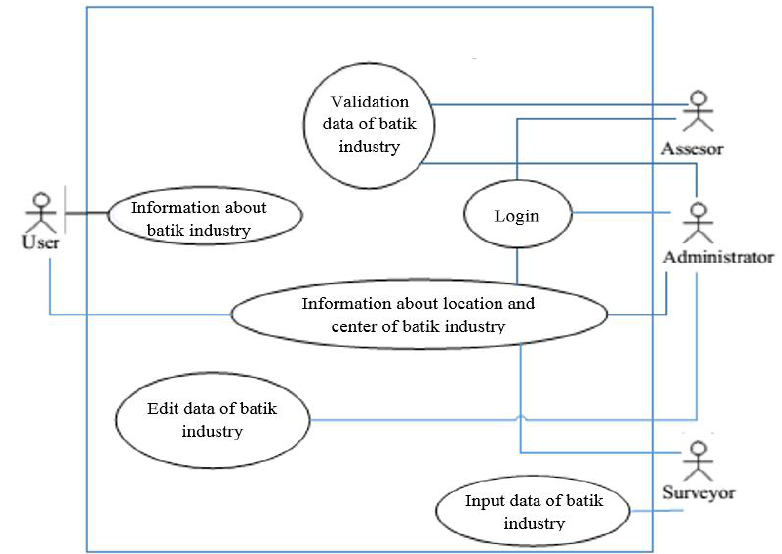
Fig. 2 The use case diagram of proposed information systems